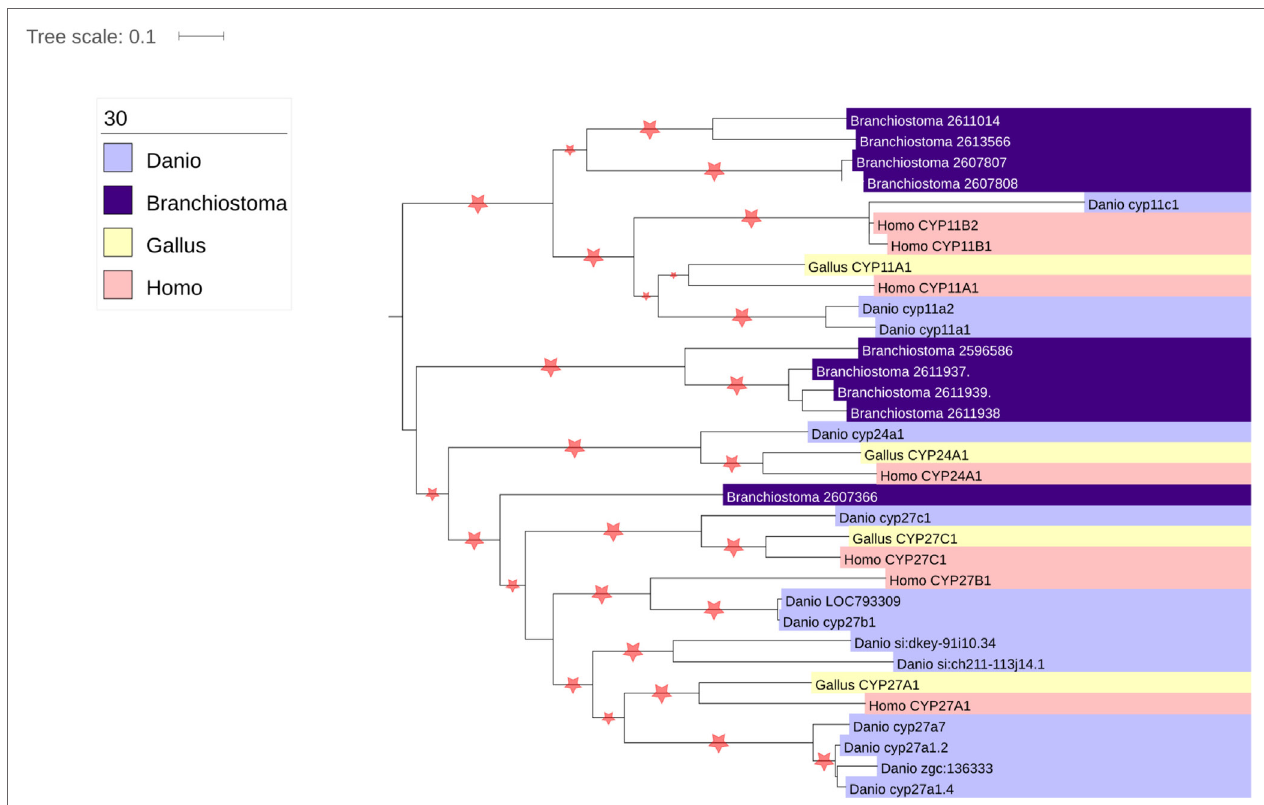
FiGURe 3 | Phylogenetic analysis of vertebrate mitochondrial CYP evolution . Homologs of the seven human mitochondrial CYPs (CYP11A1, CYP11B2, CYP11B3, CYP24A1, CYP27A1, CYP27B1, and CYP27C1) were identified using the nucleotide BLAST tool (41). Organisms chosen for search included the fully sequenced chicken ( Gallus gallus ), zebrafish ( Danio rerio ), and lancelet ( Branchiostoma floridae ), as they represented divergent vertebrate sequences (chicken vs. human vs. zebrafish) that could be compared with a non-vertebrate chordate (lancelet). The genomes of the Western clawed frog ( Xenopus tropicalis ) and anole lizard ( Anolis carolinesis ) were also searched, but sequences from these organisms were not included in the analysis as surprisingly no homologs of CYP11B1 or CYP11B2 were found ( data not shown ). Nucleotide sequences were aligned using MUSCLE (42), and phylogenetic trees constructed using PHyML